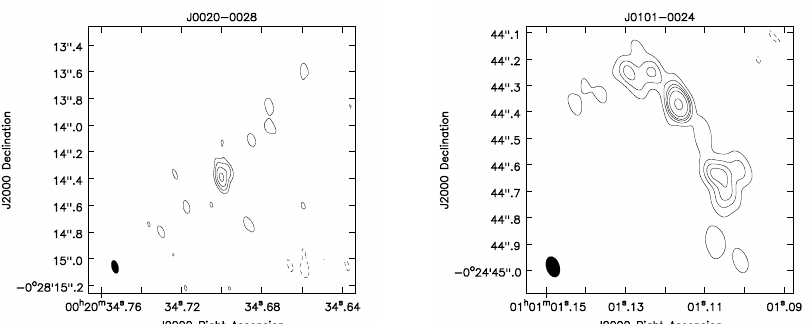
Figure 2. The 4.9 GHz maps of five FR 0s, obtained by combining the e MERLIN and JVLA visibilities. The filled area, shown at the bottom-left corner of the images, represents the restoring beam of the maps. Contours and beam parameters are given in Table